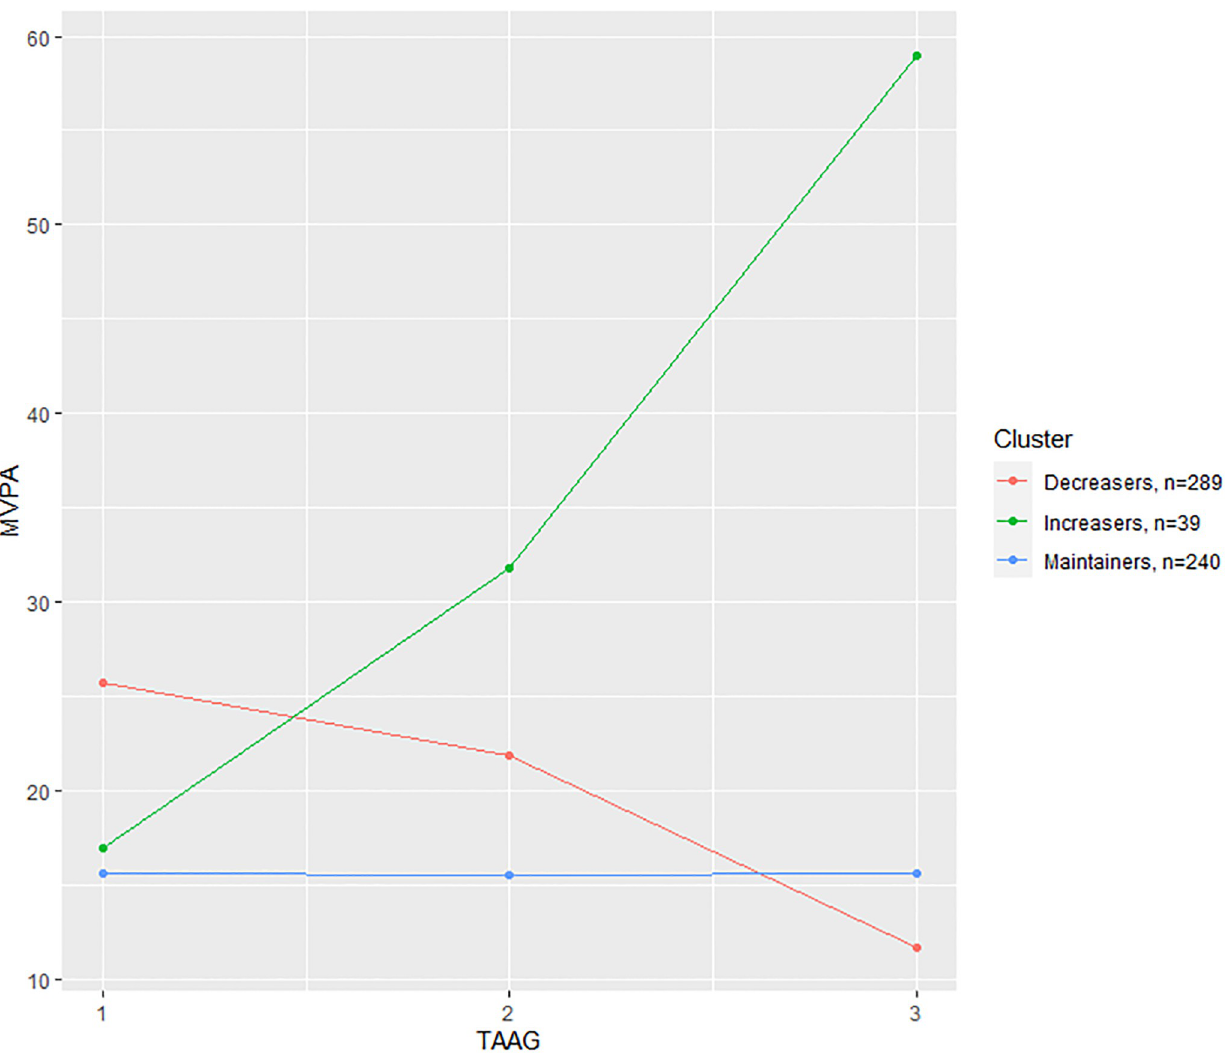
Fig 1. Mean MVPA trajectories in each cluster. Mean moderate-to-vigorous physical activity (MVPA) trajectories of the three clusters over the three TAAG waves at middle school, high school, and early adulthood, where the red line is for the Maintainer cluster, the green line is for the Decreaser cluster, and the blue line is for the Increaser